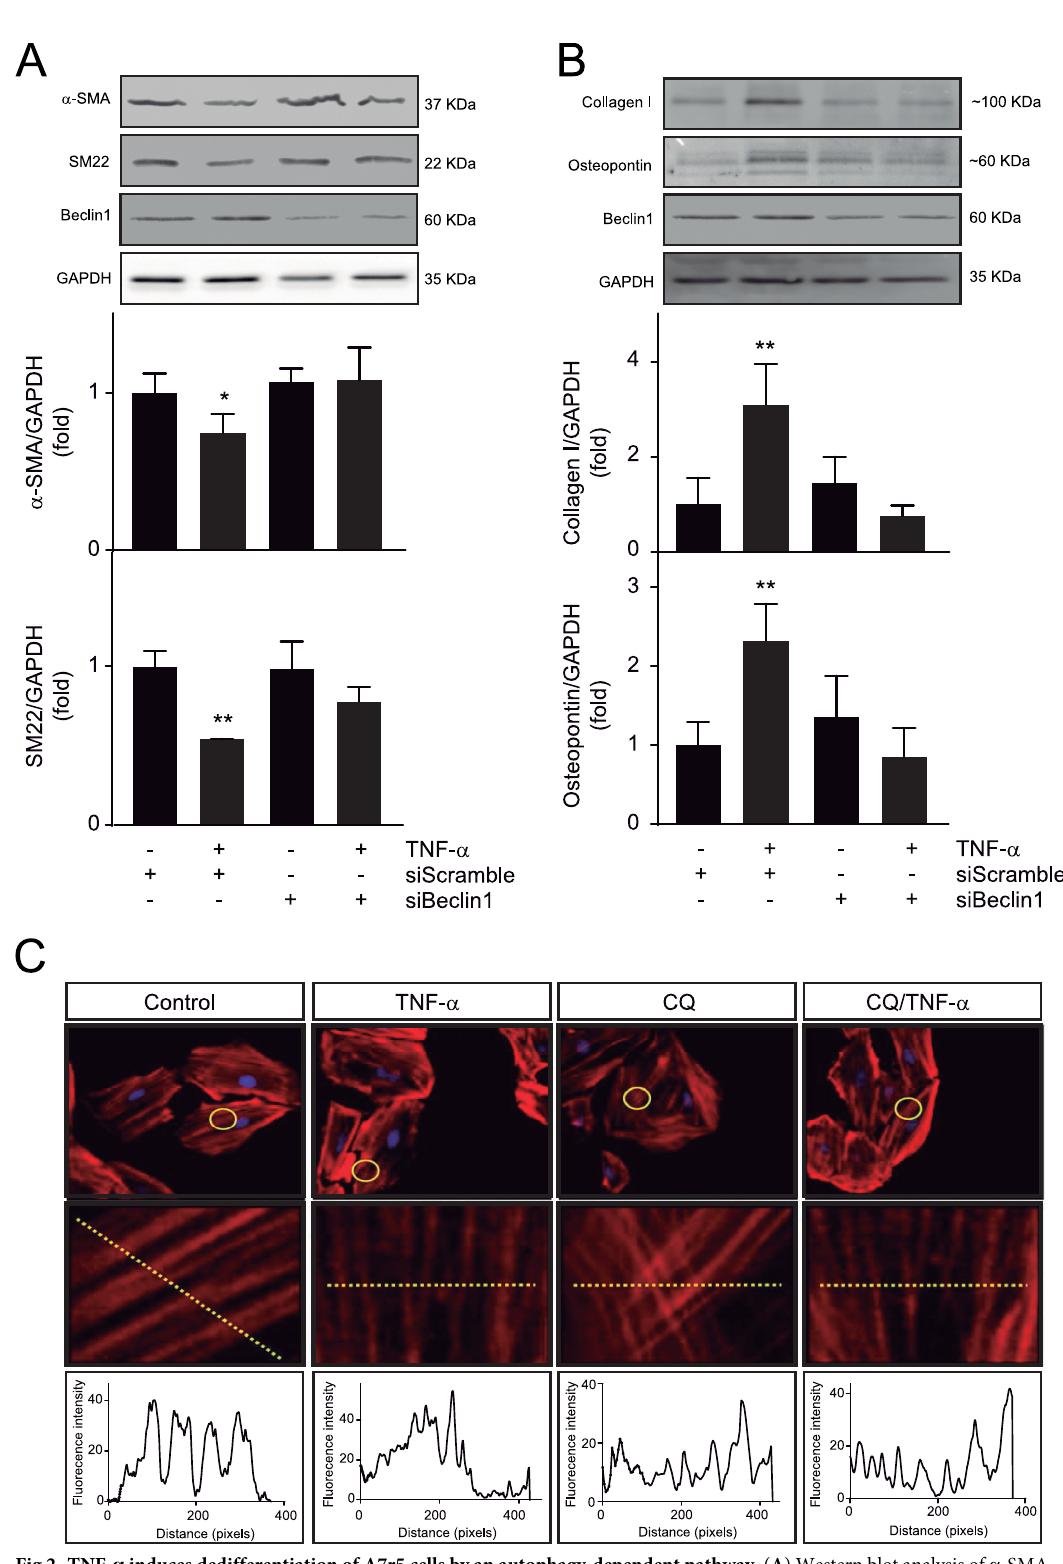
Fig 2. TNF- α induces dedifferentiation of A7r5 cells by an autophagy-dependent pathway. ( A ) Western blot analysis of α -SMA and SM22 (n = 3–4; (cid:3) p < 0.05, (cid:3)(cid:3) p < 0.01 vs control) or ( B ) collagen type I and osteopontin (n = 3–4; (cid:3)(cid:3) p < 0.01 vs control) in A7r5 cells incubated with TNF- α (100 ng/mL) for 48 h in the presence or absence of siScramble and siBeclin1. GAPDH was used as